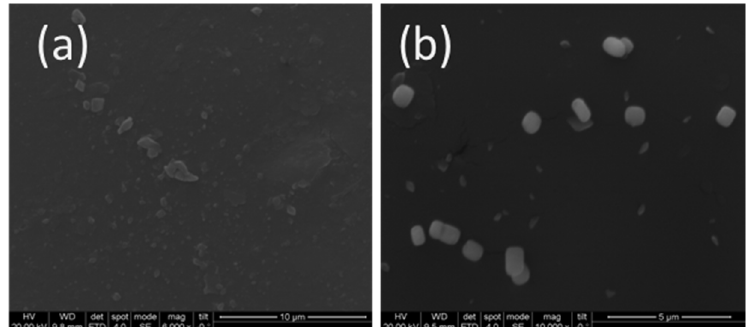
Figure 3. SEM images of ( a ) 2GO-Ag-PVA ( b ) 2GO-Ag-PVA (IL).